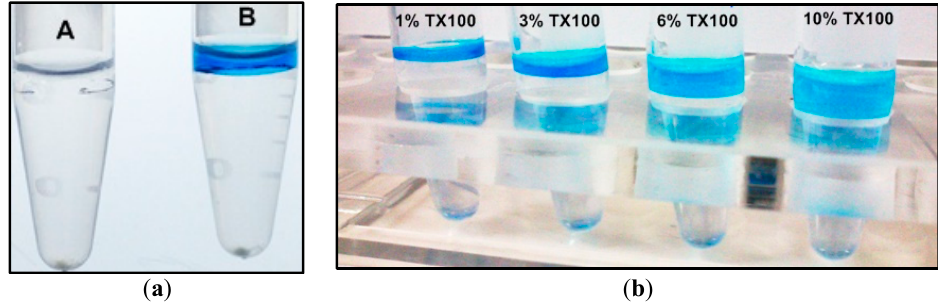
Figure 1. TX-100 two-phase separation performed at ambient temperatures induced by NaCl and coomassie blue added as a phase boundary indicator: ( a ) (A) without and (B) with visualizing dye; and ( b ) stable two-phase separation with increasing amount of TX-100 as marked.